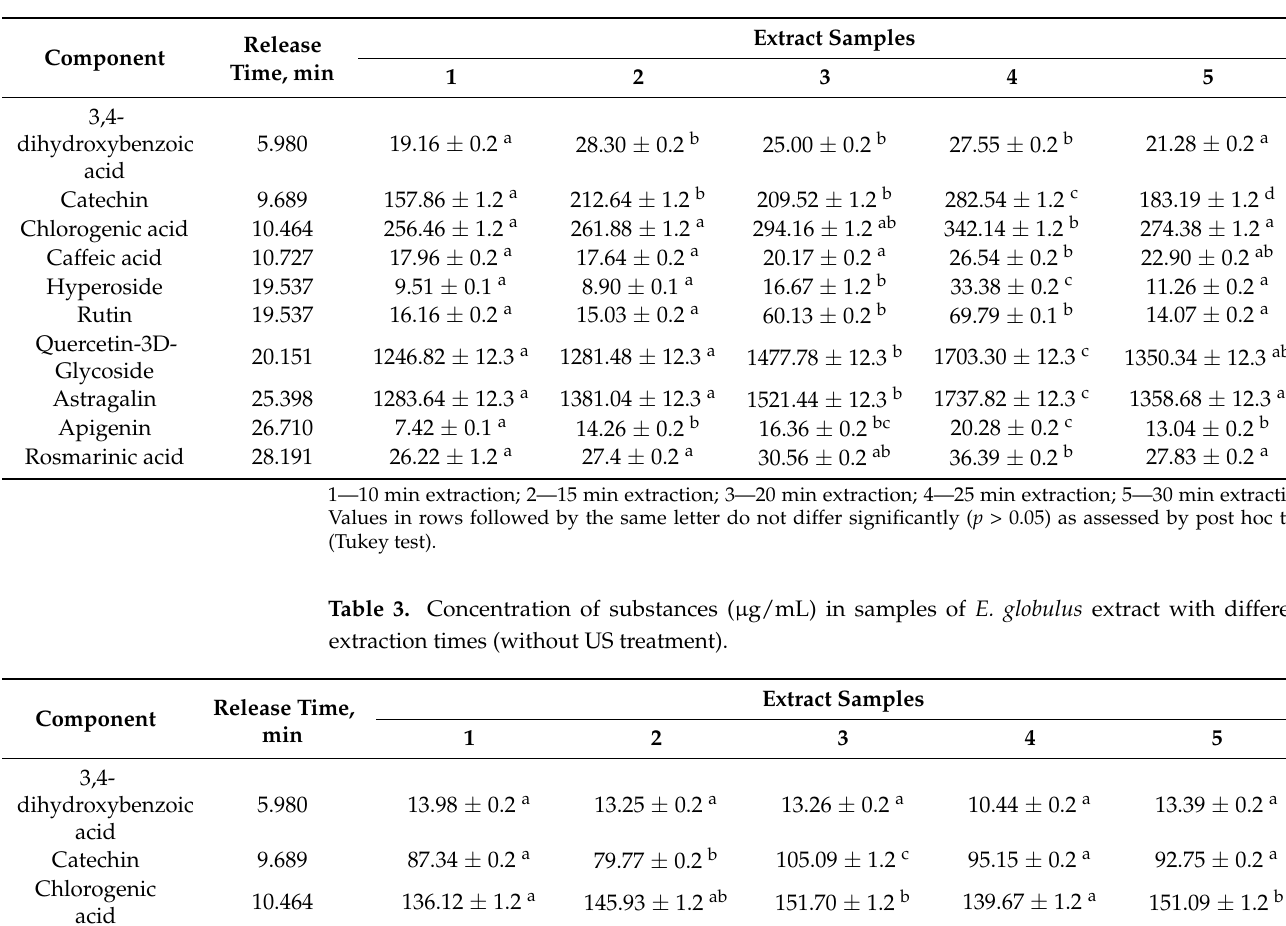
Table 2. Concentration of substances ( µ g/mL) in samples of E. globulus extract with different extraction times (with US treatment).